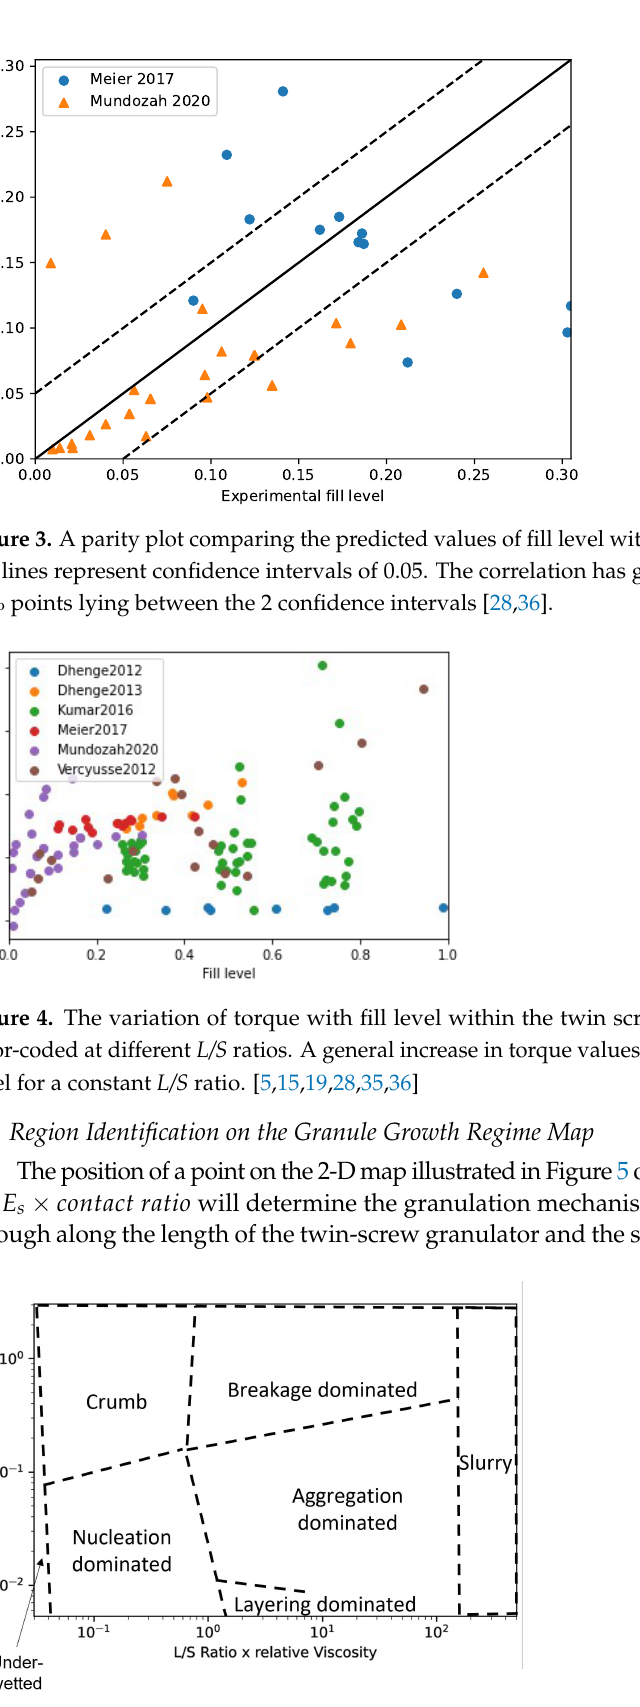
Figure 5. Proposed boundaries for the proposed regime map to differentiate between different growth granule